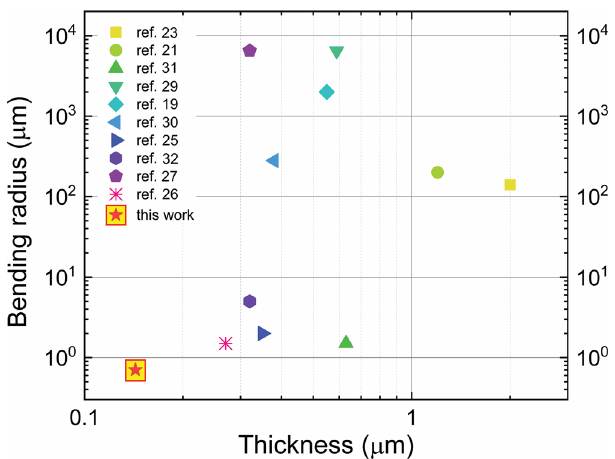
Fig. 5 State of the art on super/ultra-thin transistors. Comparison graph of superthin and ultrathin organic fi eld-effect transistors. In the x -axes, the total thickness is reported, and the minimum bending radius is in the y